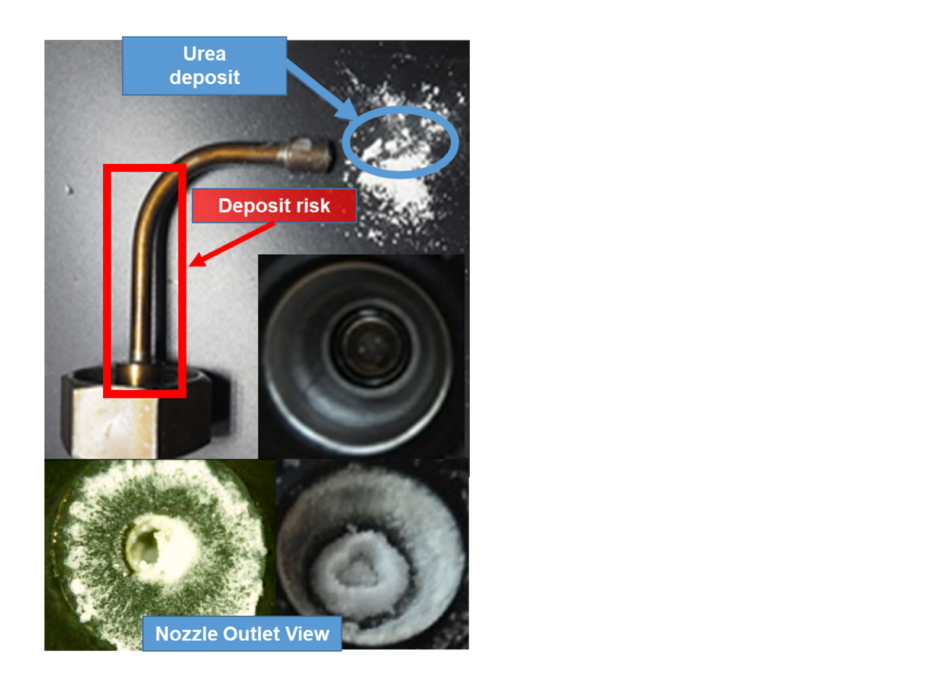
for improving NOx conversion in heavy-duty diesel engines, particularly the Hyundai D6CC [39,122].